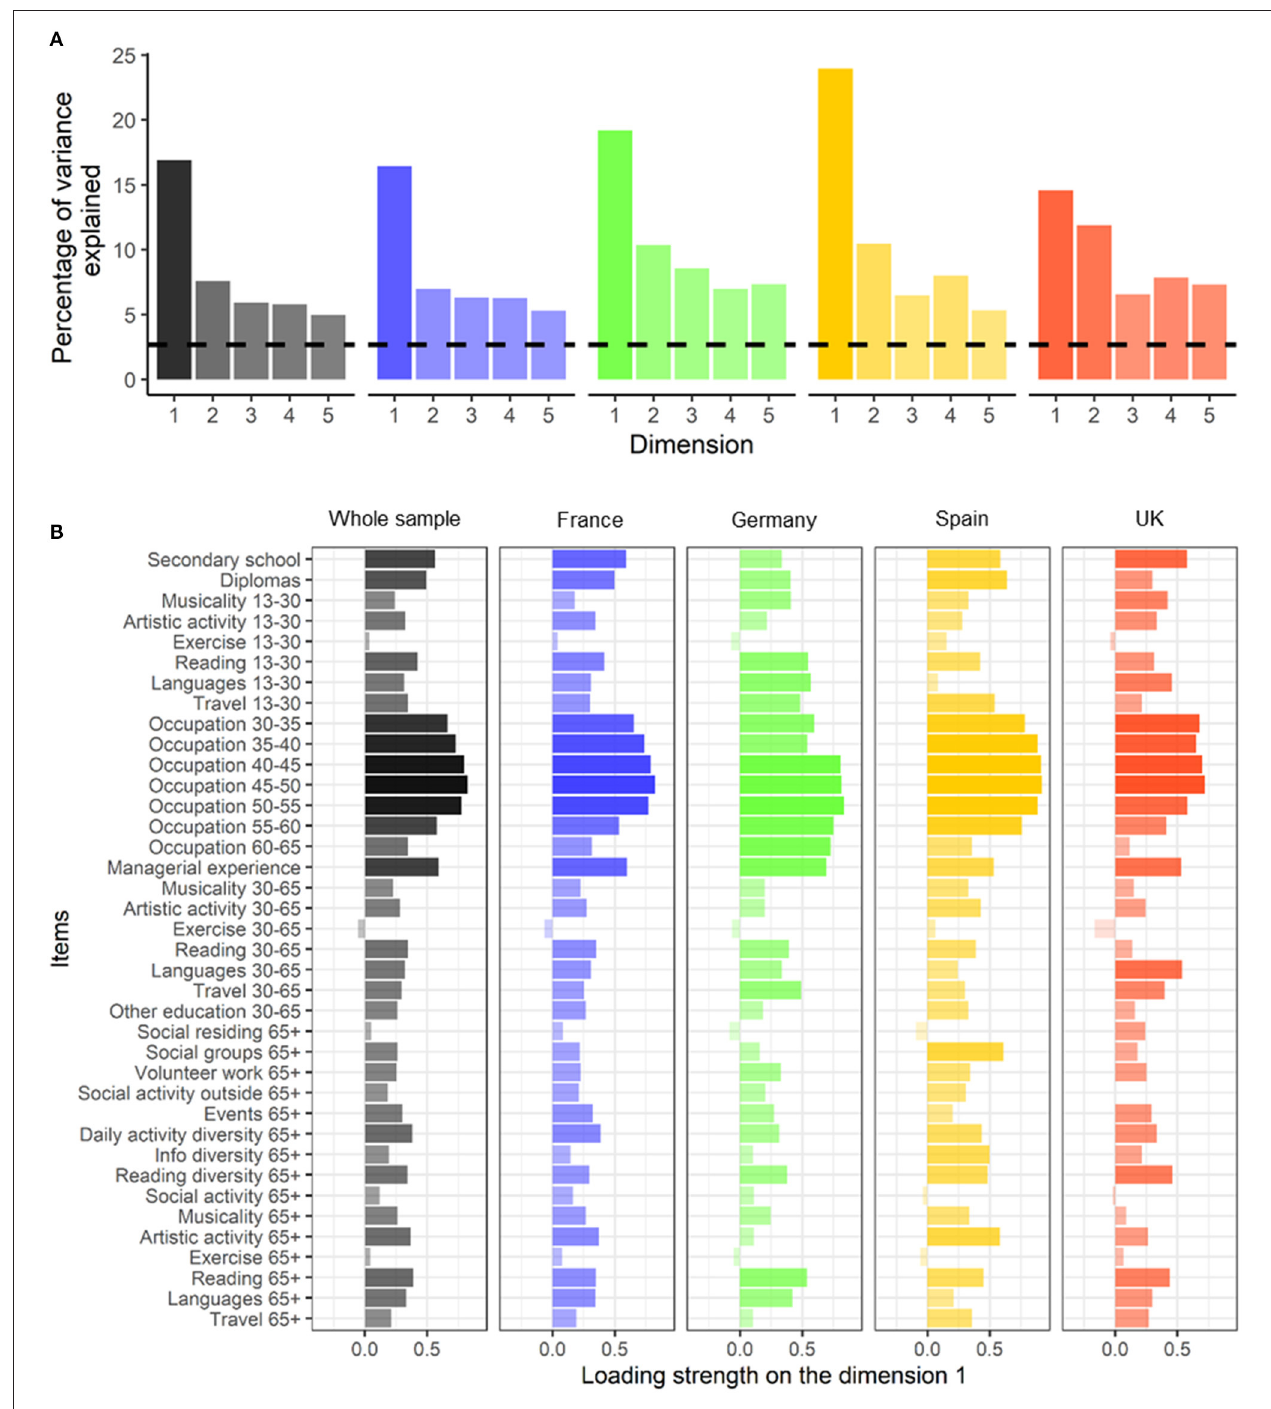
FIGURE 2 | Structural validity: Scree plot of the percentage of variance explained by the first five dimensions of the LEQ (A) and loading strength of the LEQ items (unrotated coordinates) on the first dimension (B) in the whole sample (black) and within each country (France, blue; Germany, green; Spain, yellow; United Kingdom, red). Black dashed line is the common threshold eigenvalue of 1 corresponding to 2.6% variance explained (i.e., the eigenvalue divided by 38 items). 13–30, period between 13 and 30 years old; 30–65, period between 30 and 65 years old; 65 + , period beyond 65 years old.